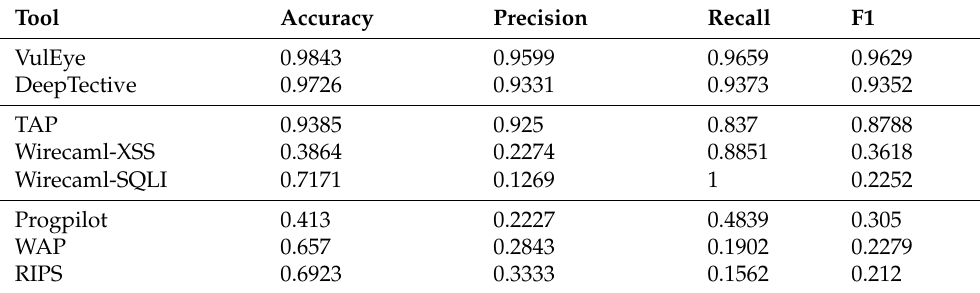
Table 10. Tools’ Results Comparison.